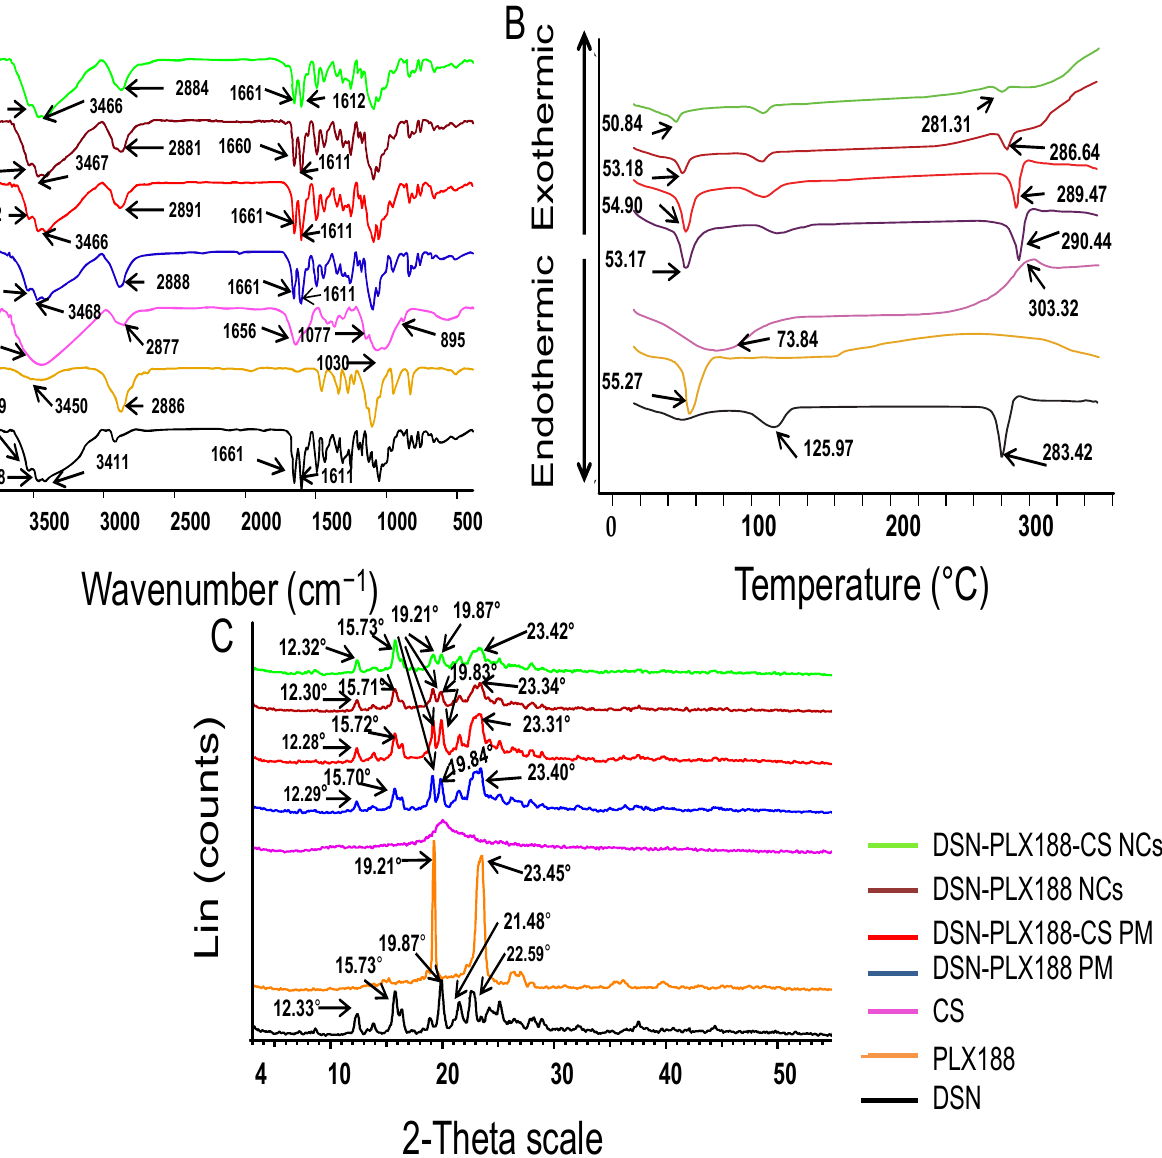
Figure 4. Solid-state characterization of the lyophilized selected NCs in comparison with DSN powder, individual polymers and the corresponding PMs. ( A ) FT-IR spectra, ( B ) DSC thermograms and ( C ) XRD